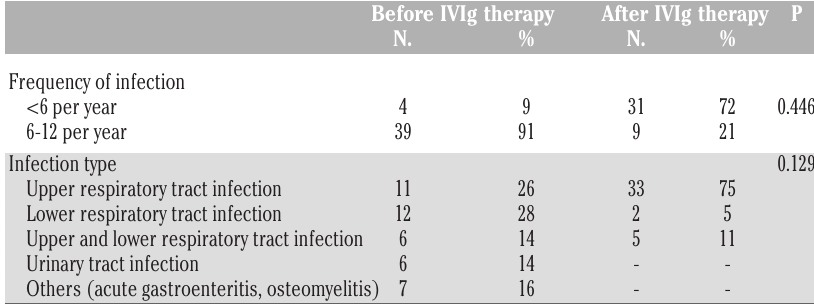
Table 2. Frequency and type of infections in intravenous immunoglobulin-treated tran- sient hypogammaglobulinemia patients